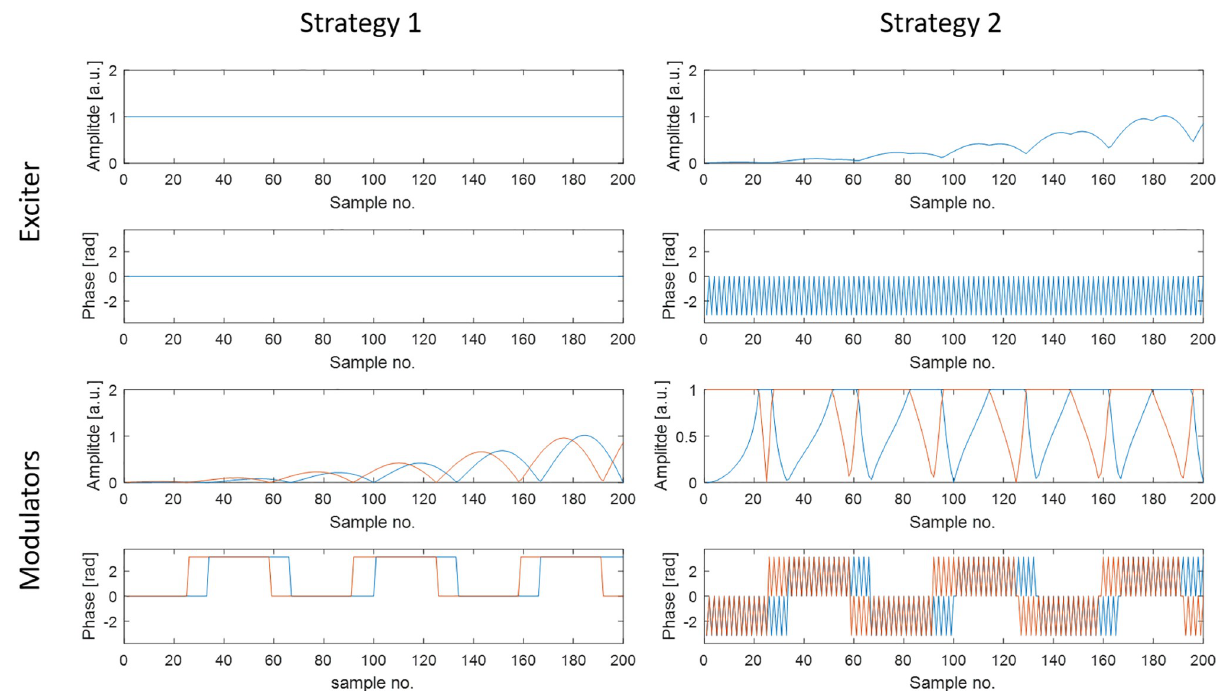
Fig 2. Simplified representation of two modulation strategies using two channels. Strategy 1 plays out a rectangular pulse on the exciter and performs the entire modulation with the IQ modulators. Strategy 2, which is used in the implemented system, uses a pre-modulated signal from the exciter to always use the full dynamic range of the modulators, as well as a 180˚ change in phase from sample to sample to minimize the effect of systematic errors in the modulators.